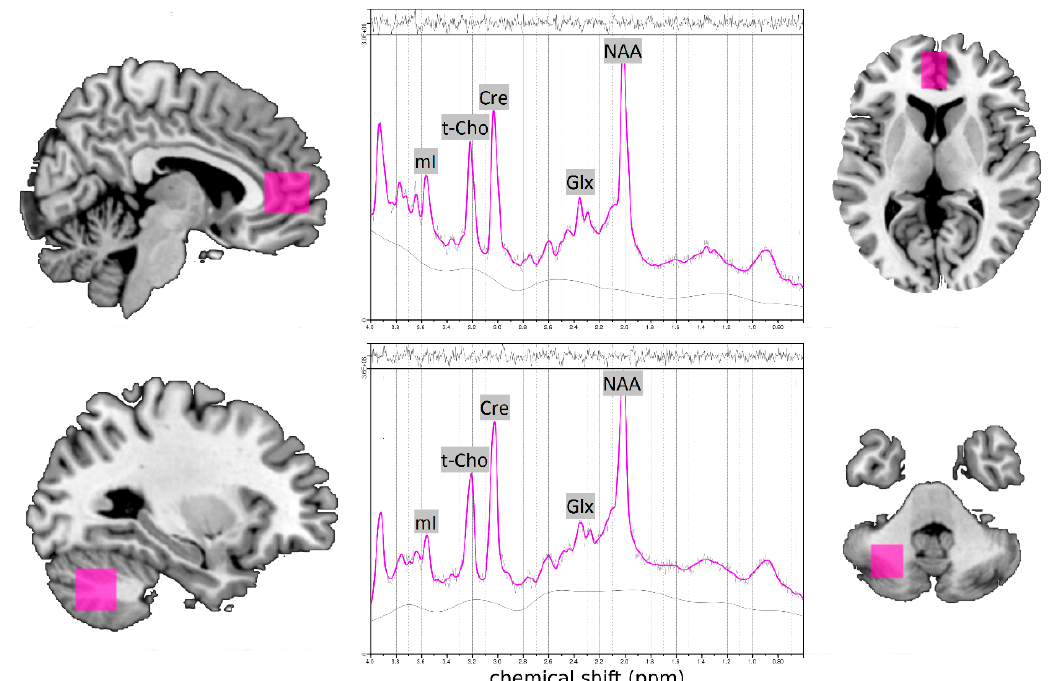
Figure 1. Voxel localization for MRS measurements in the pregenual anterior cingulate cortex (ACC; top left and right) and in the left cerebellum (CHL; bottom left and right) and illustrative spectra from the ACC and CHL of participants (in the middle) (adopted by Endres et al. [48]). Abbreviations: Cre, creatine; Glx, glutamate + glutamine; mI, myo-inositol; NAA, N-acetylaspartate, ppm, parts per million, t-Cho, total choline compounds including phosphorylcholine + glycerylphosphorylcholine.